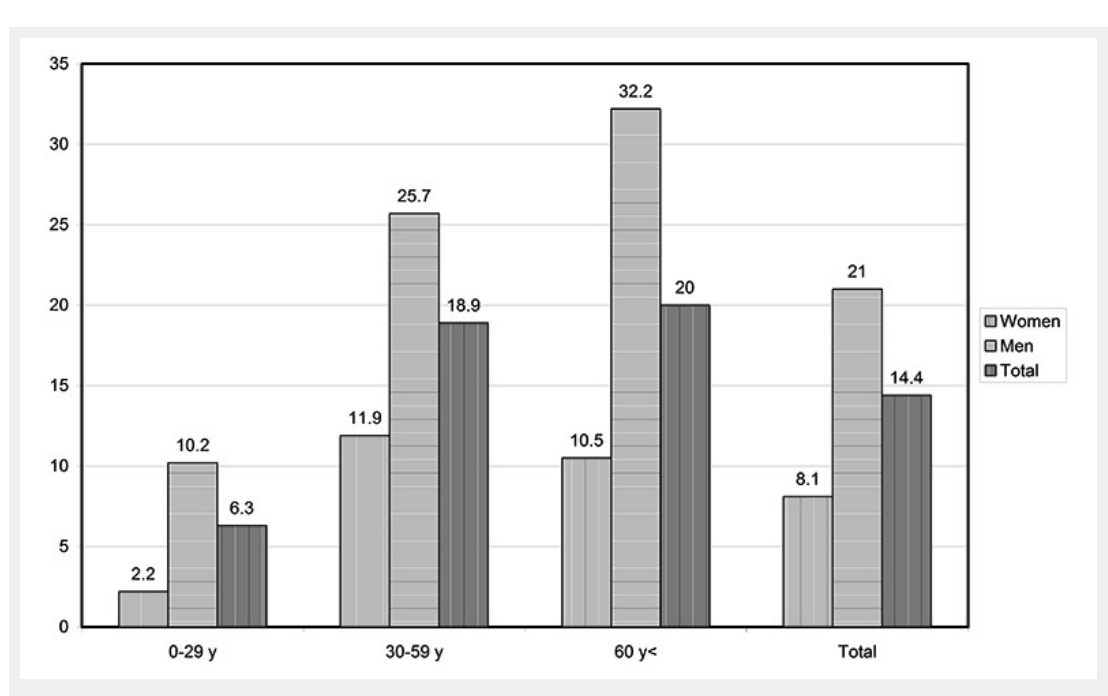
Suicide Rate per 100,000 Inhabitants and Year Including Assisted Suicide by Age Group and Sex (n = 256).